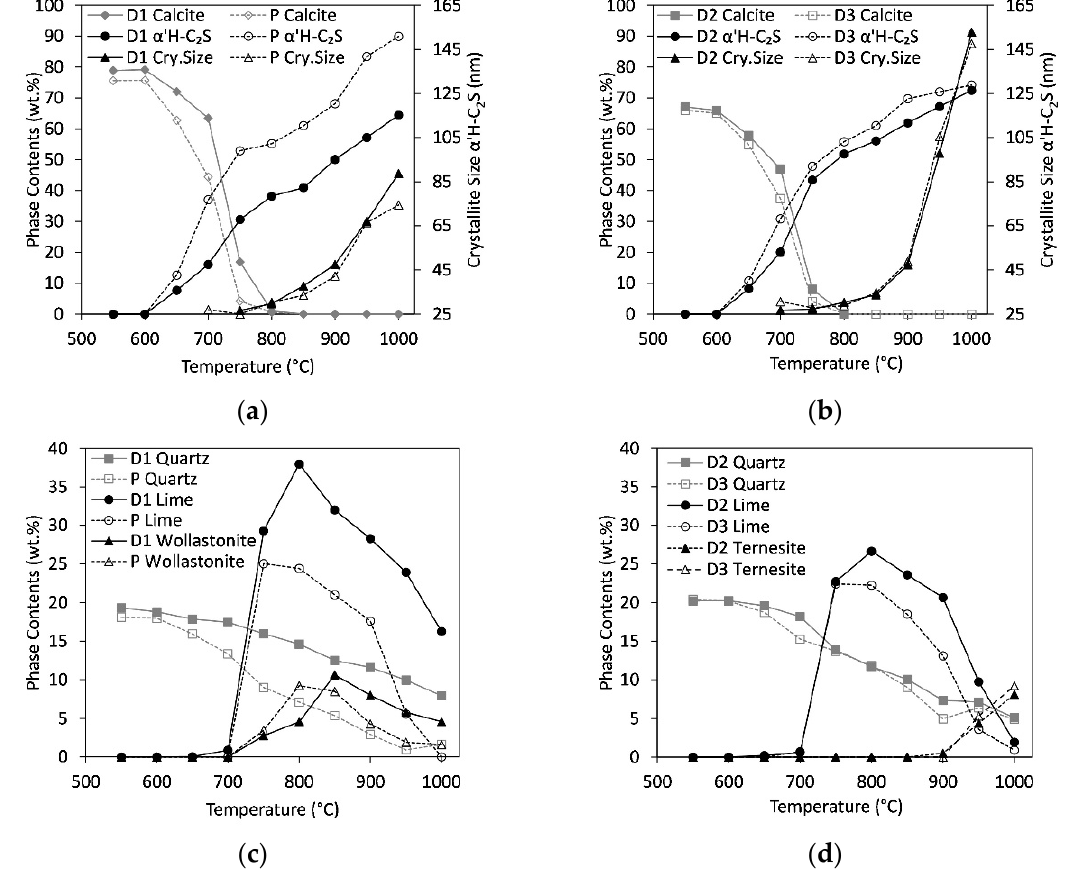
Figure 3. Thermal treatment of autoclaved aerated concrete with calcite (C/S = 2, step50). Variation of calcite and α ’H-C 2 S phase contents and crystal size of α ’H-C 2 S for samples D1 and P ( a ) and D2 and D3 ( b ). Variation of phase contents of quartz, lime, and wollastonite for samples D1 and P ( c ) and phase contents of quartz, lime, and ternesite for samples D2 and D3 ( d ).